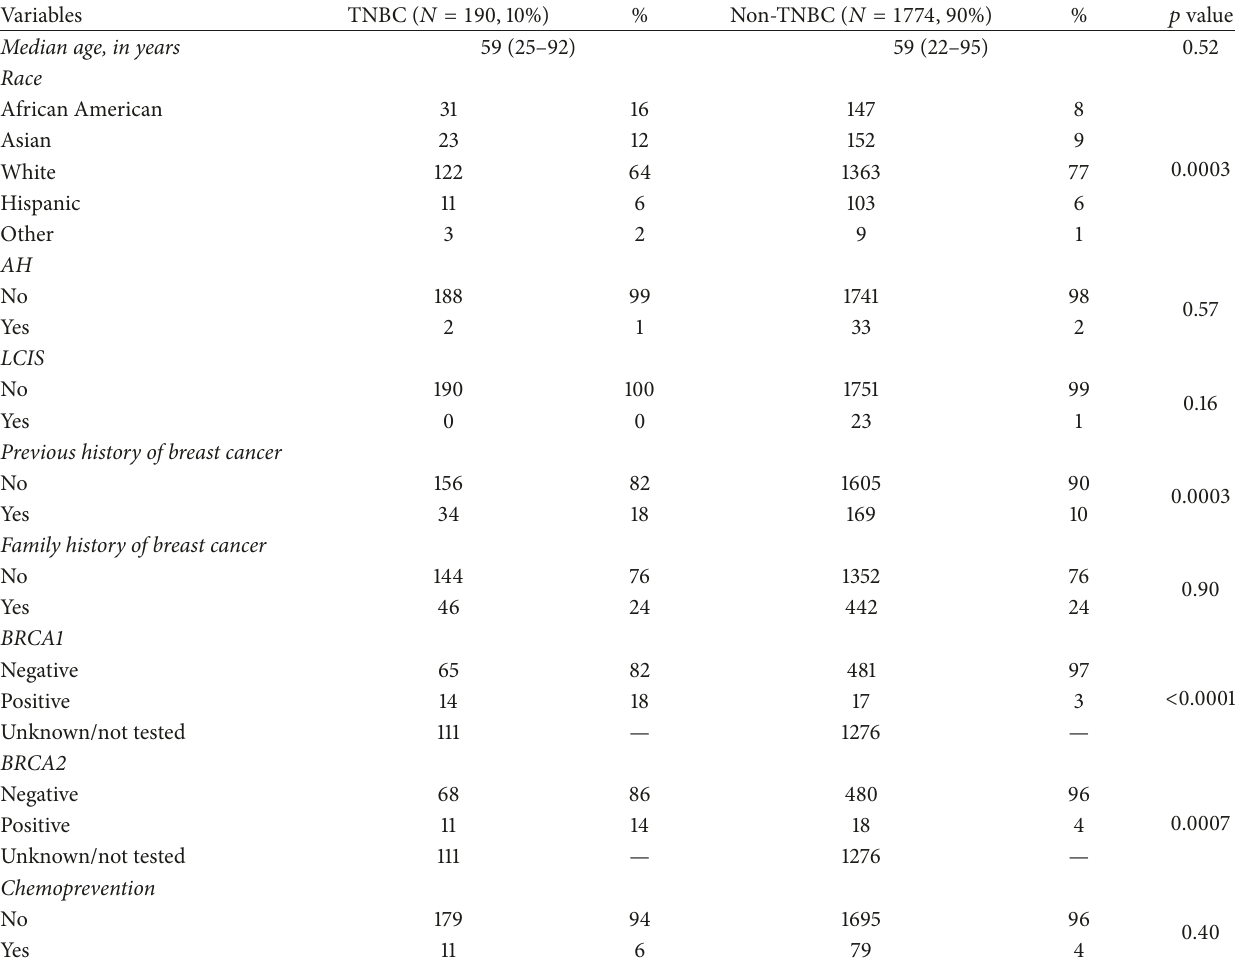
Table 1: Clinical characteristics.